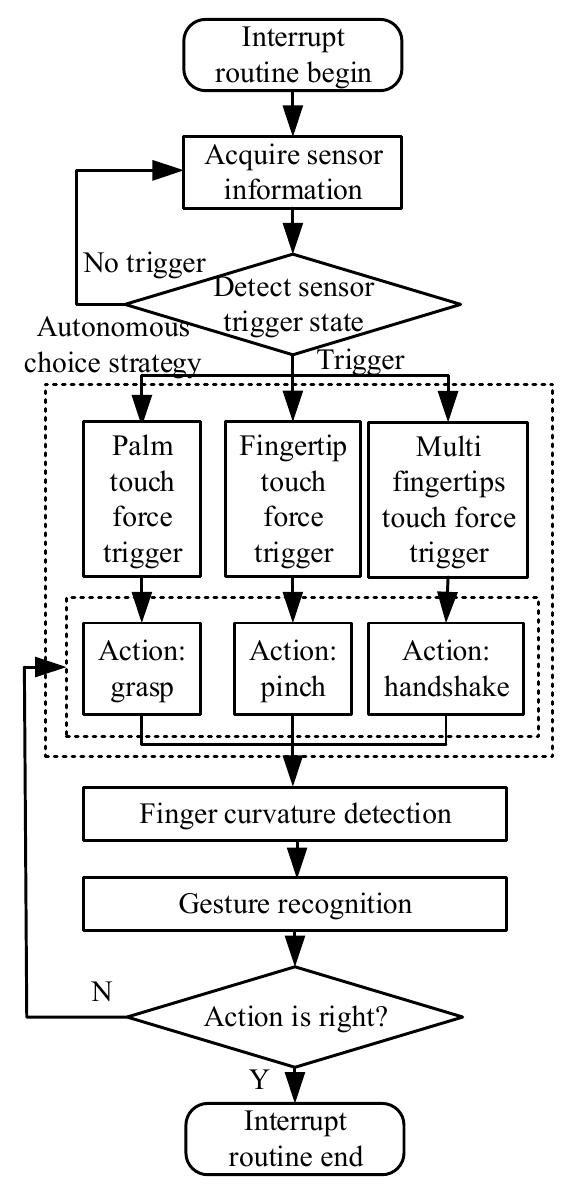
Figure 5. The program flow of TDO.